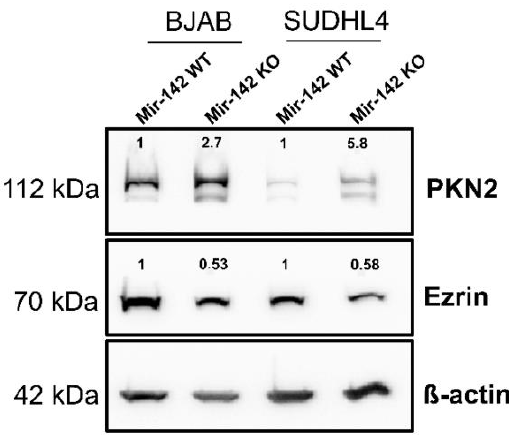
Figure 11. Western blot analysis: Extracts of BJAB-wild-type and SUDHL4-wild-type (“WT”) cells and the corresponding miR-142 knockout (“KO”) cells were separated on a 10% polyacrylamide gel, transferred to a nitrocellulose membrane and incubated with antibodies against PKN2, Ezrin and β -actin as a loading control. The membranes were incubated with the appropriate secondary antibodies coupled to horseradish peroxidase. Bound secondary antibodies were visualized by ECL. The bands were quantified using Image Lab 6.0.1. The mean value of two separate experiments is shown above the bands. The wild-type value was set to 1. The uncropped blots are shown in Figure